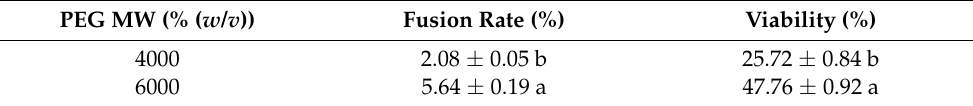
Table 6. Effect of different molecular weight of PEG on protoplast fusion between J. sambac L. and J. mesnyi